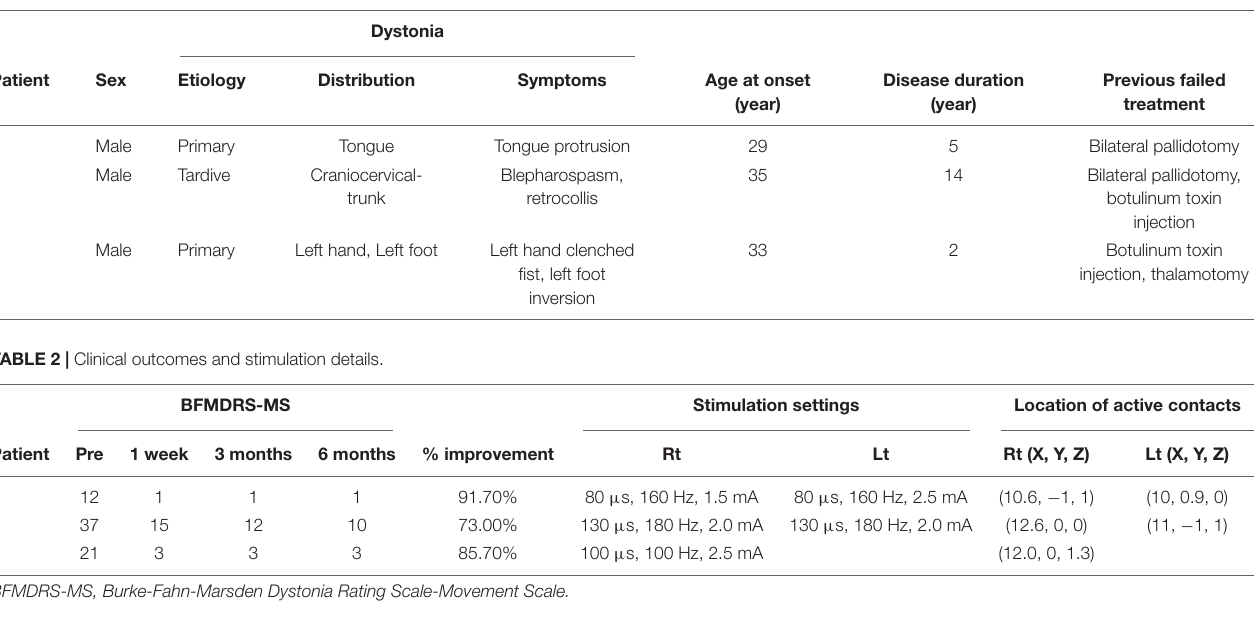
TABLE 1 | Patient characteristics.